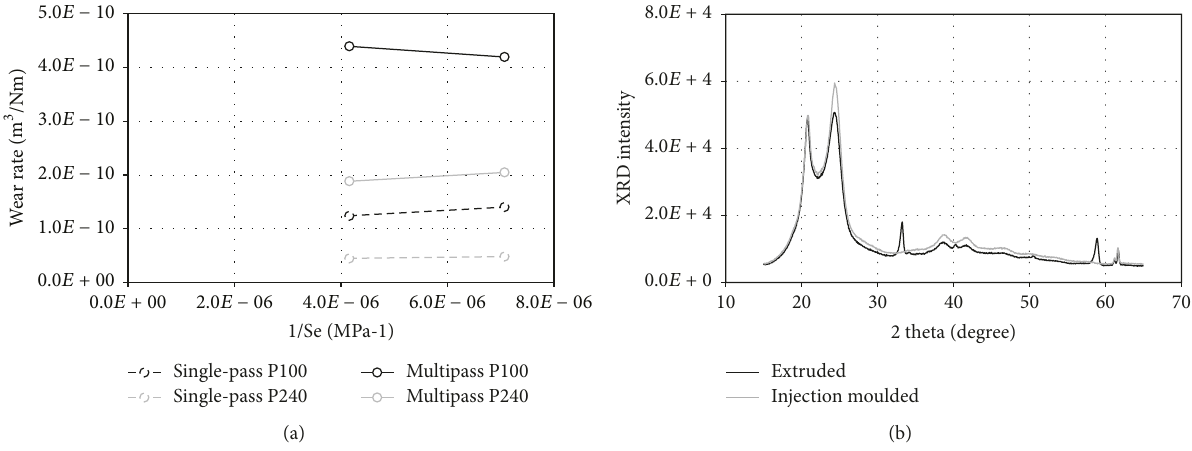
Figure 4: (a) Specific wear as a function of 1/Se (20 N normal force) and (b) XRD (WAXD) of unworn injection moulded and extruded